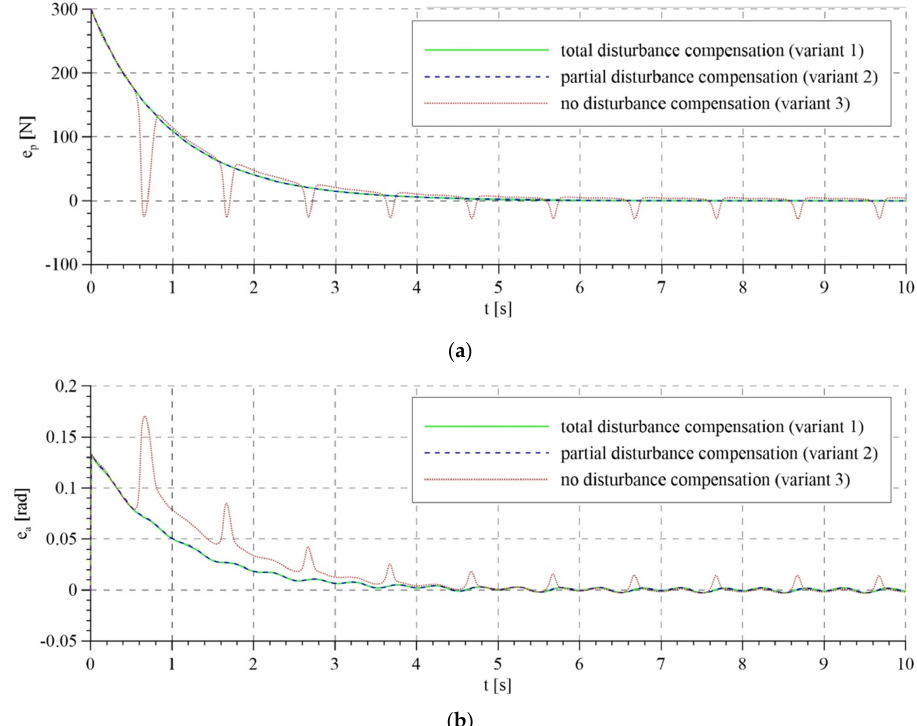
Figure 9. Tracking errors for the adaptive control system: ( a ) tracking error of the passive part of the system—force error; ( b ) tracking error of the active part of the system—rotation angle error.